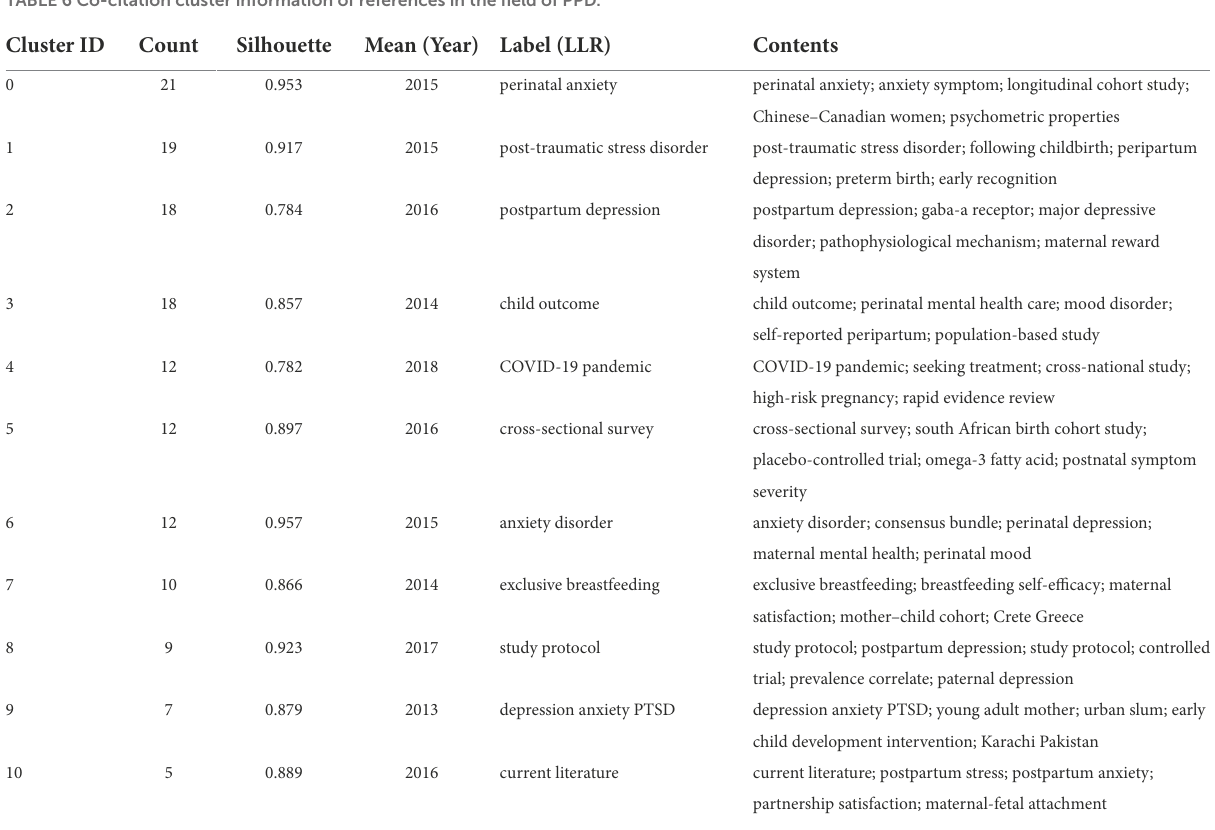
TABLE 6 Co-citation cluster information of references in the field of